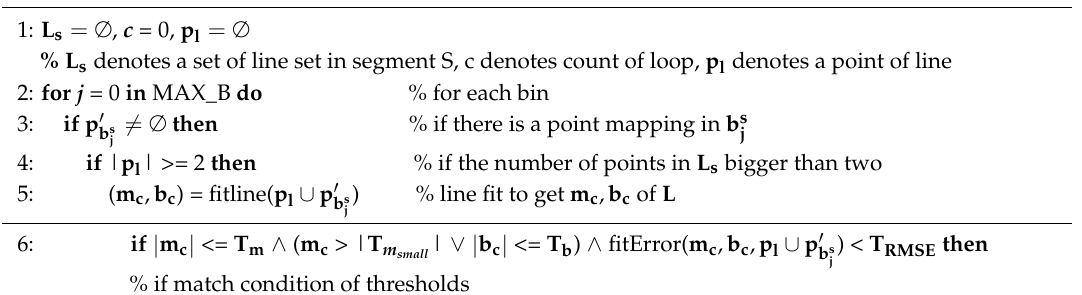
Algorithm 1. Extraction of lines for one segment S S